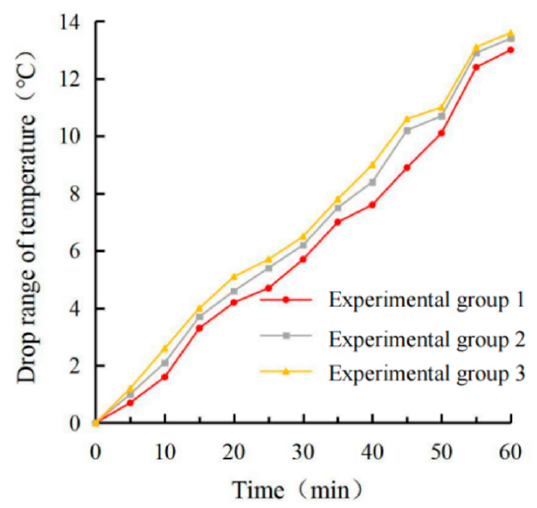
Figure 15. Surface cooling value diagram.